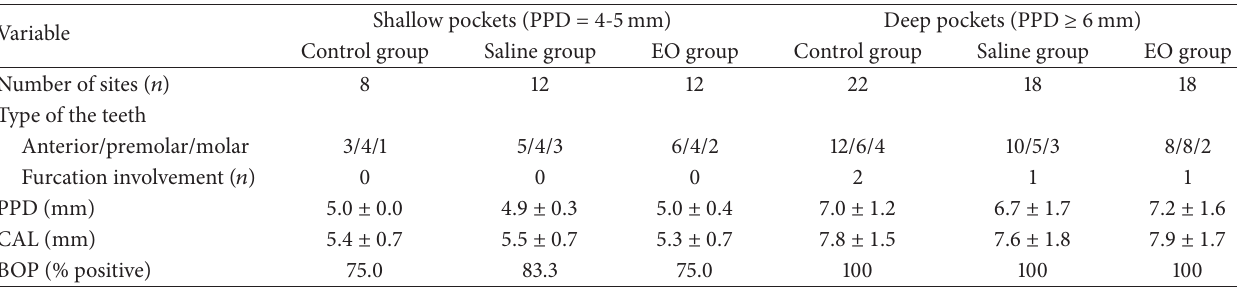
Table 2: Clinical characteristics of sampling